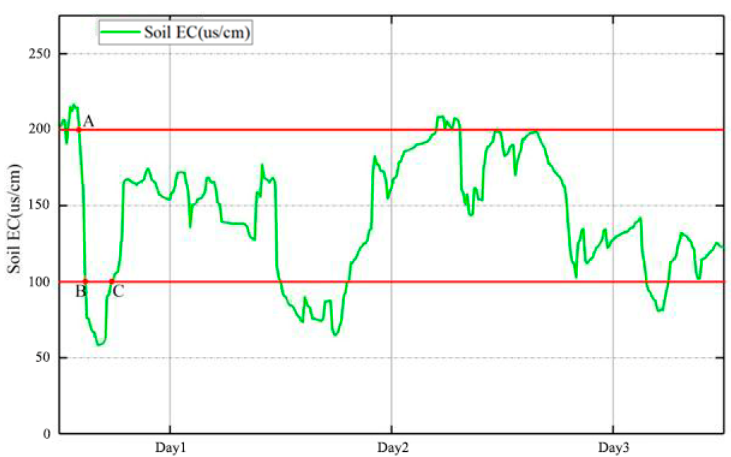
Figure 7. Measured and calculated data of soil EC used by the proposed system over 3 days.